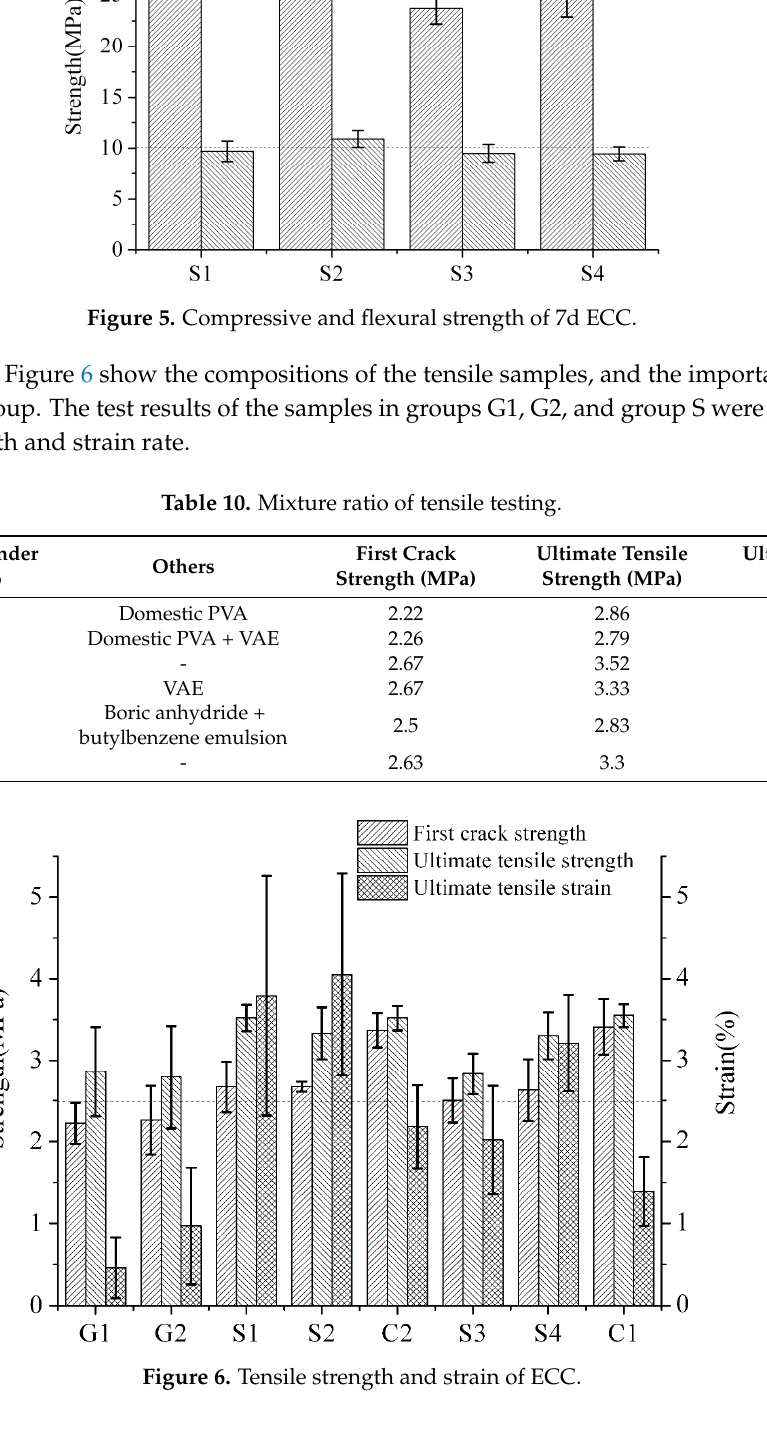
Figure 7. Stress-strain curve of G1 and G2. Groups G1 and G2 used domestic PVA fibers (manufactured by Sinopec Chongqing SVW Chemical Co., Ltd., Chongqing, China), and the water–binder ratio was 0.3. The PVA in group G2 was soaked in boric anhydride–butadiene–styrene emulsion diluent for 10 min prior to use, and it was removed and baked at low temperature until it was half-dry. Afterwards, extra emulsion was washed away by water, and the PVA was re-baked for use. A polymer film with acidity will form after processing of the surfaces of the fibers. Due to the domestic fibers’ surfaces not being processed, –C–OH composite clusters on the surfaces of the PVA fibers can form firmly combined hydrogen bridges with –OH in the cementitious composites [38]. In addition, the diameter and the strength-of- tensile resistance of a single thread of domestic fiber are weaker than that of the imported fibers. All of these factors increase the probability of the occurrence of fractures at the early stage of cracking in the cementitious composites, and increase their inability to transmit stress and or to utilize better